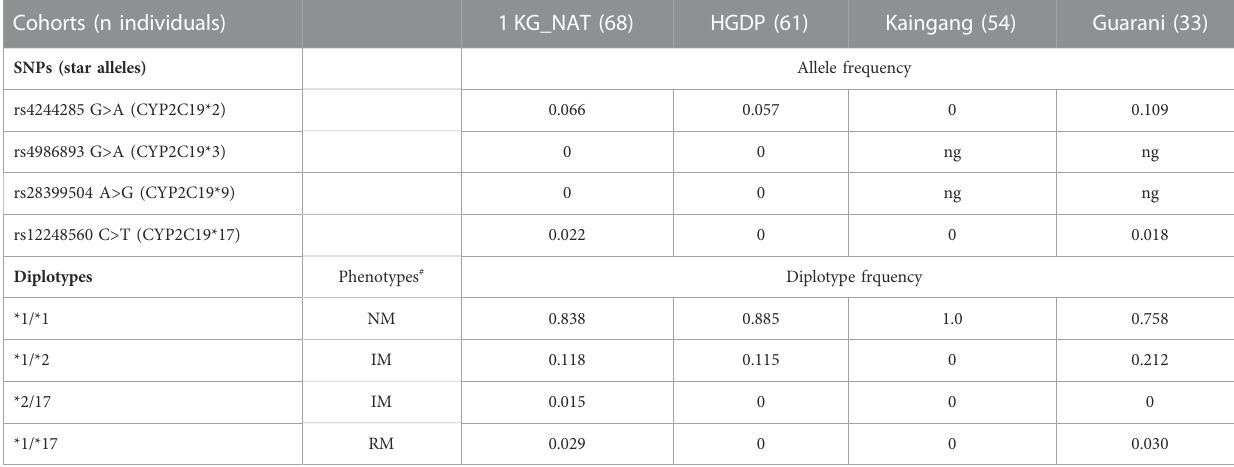
TABLE 2 Distribution of CYP2C19 alleles, diplotypes and assigned phenotypes. Cohorts (n individuals)